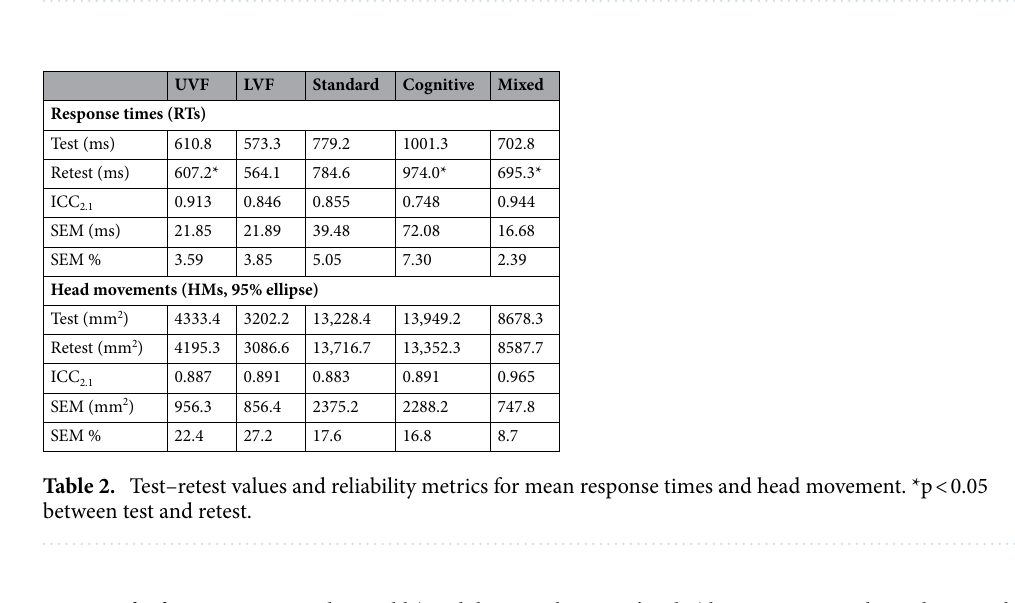
Table 1. Mean SSQ scores or subscale scores as a function of qualitative variable. Values are mean ± SD.